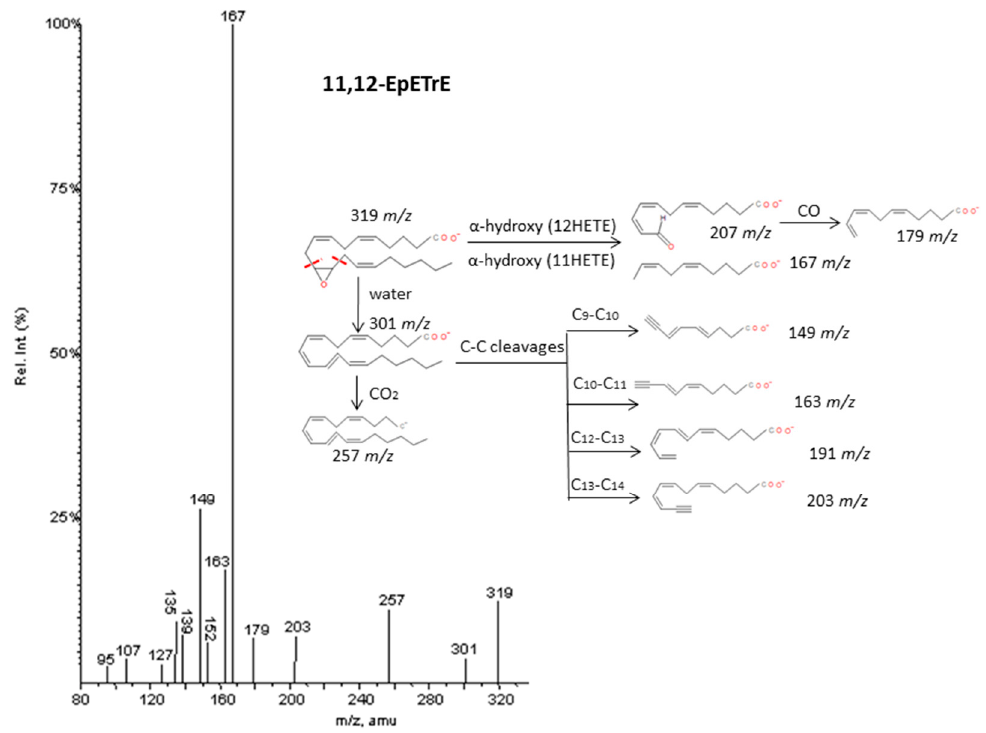
Figure 7. Fragmentation pattern suggested for 11.12-EpETrE. The product ion spectrum at m/z 319 was obtained from database of LIPID MAPS at CID 30V.